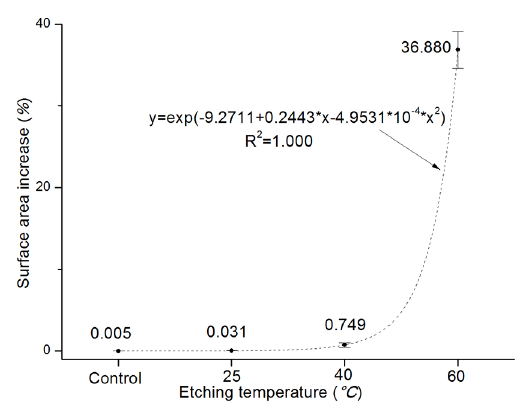
Figure 3. Ti6Al4V surface area changes as a function of etching temperature.